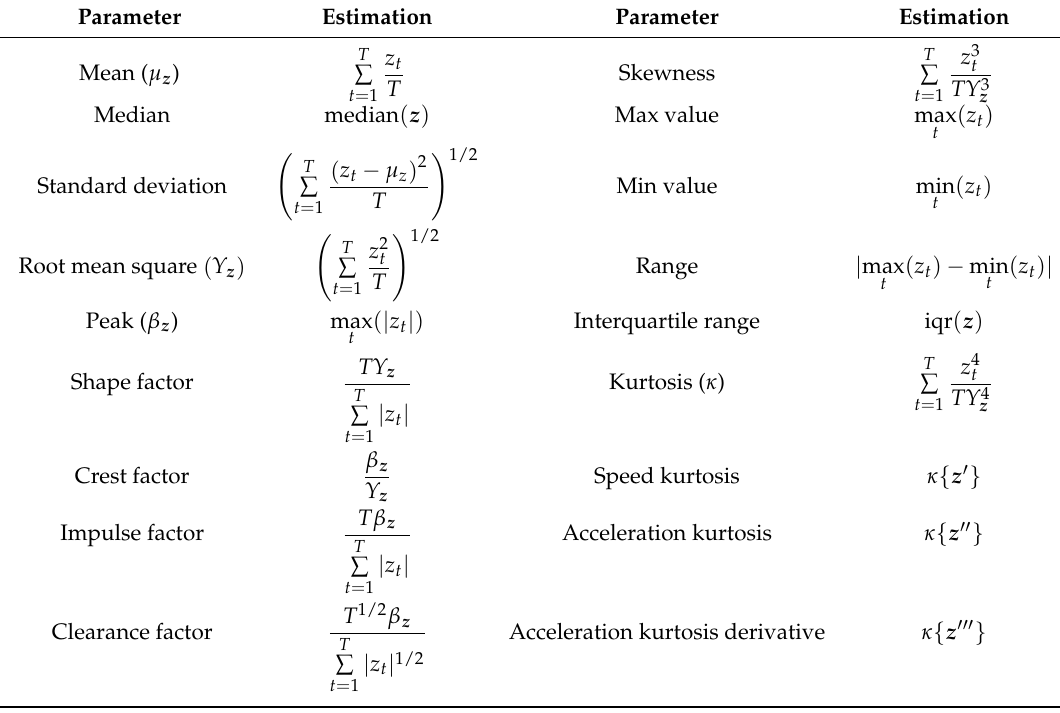
Table 1. Time domain features ( T ). Time-based parameters are computed for each vibration segment z . Parameter Estimation Parameter